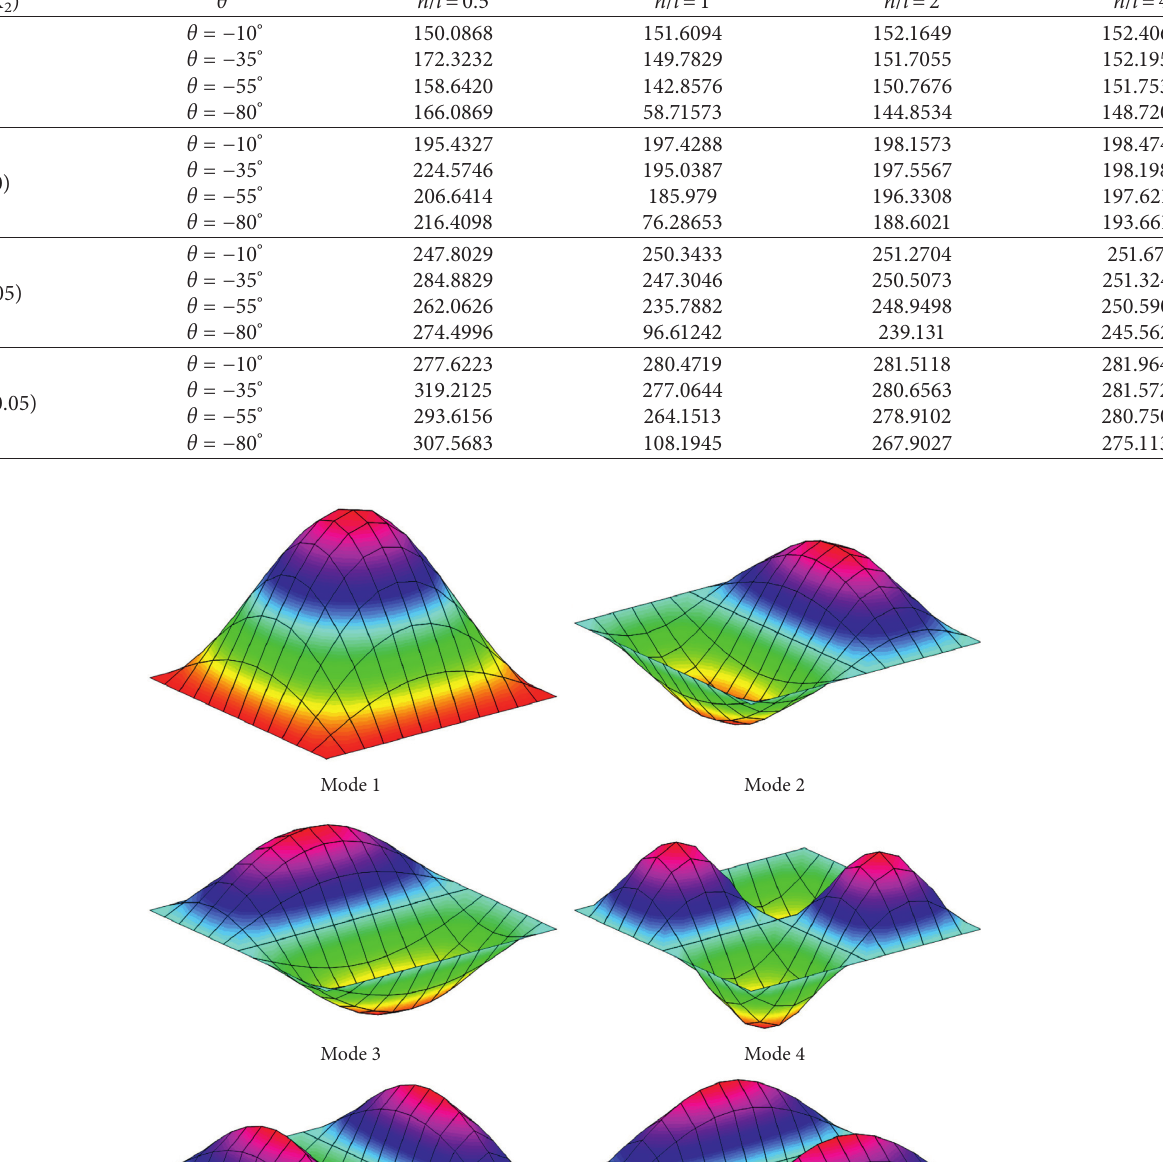
� 1.5, h � h � 20 h , θ � − 55 ° , h / l � 2, t / l � 0.1385, and K 2 / h 1 1 3 , a